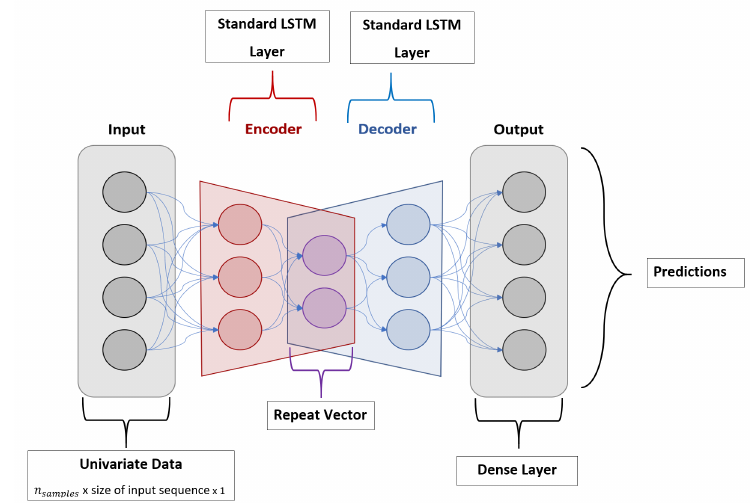
Figure 7. Autoencoder LSTM